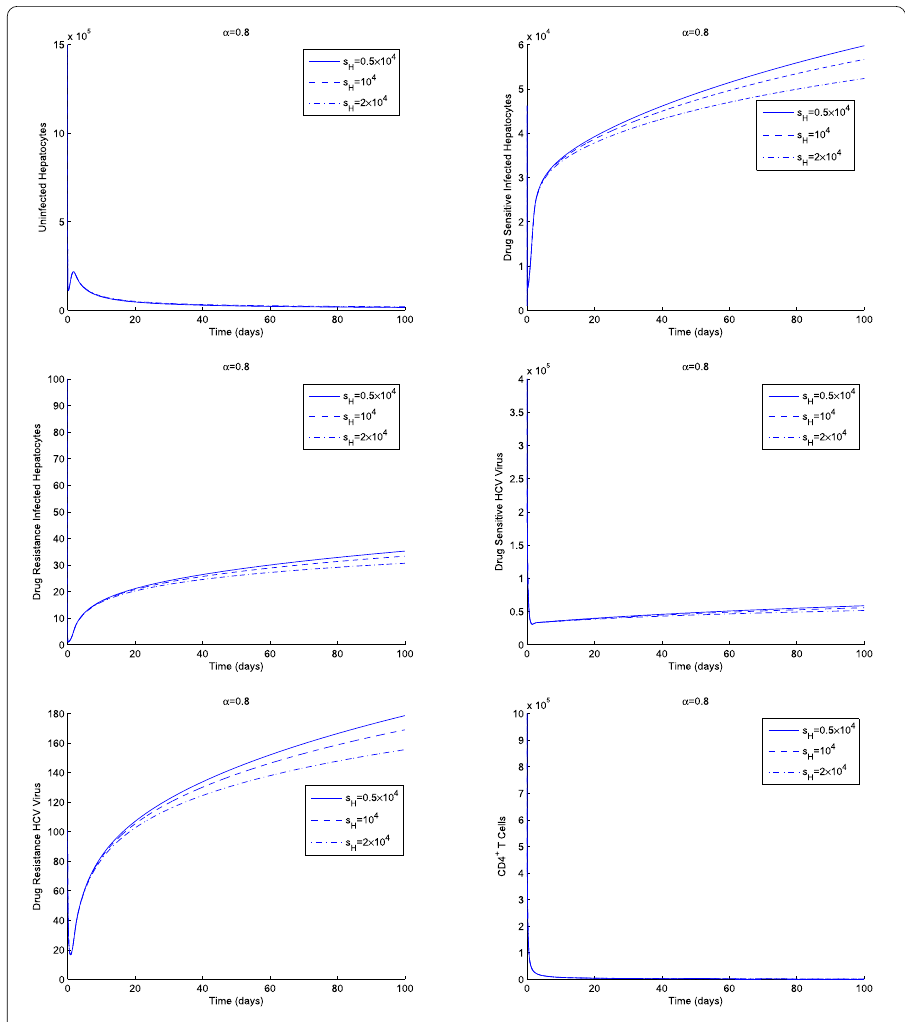
Figure 11 Dynamics of the variables of system (1) for different values of s H , the CD4 + T cells recruitment rate, and α = 0.8. Parameter values are in Table 1 and initial conditions are given in the